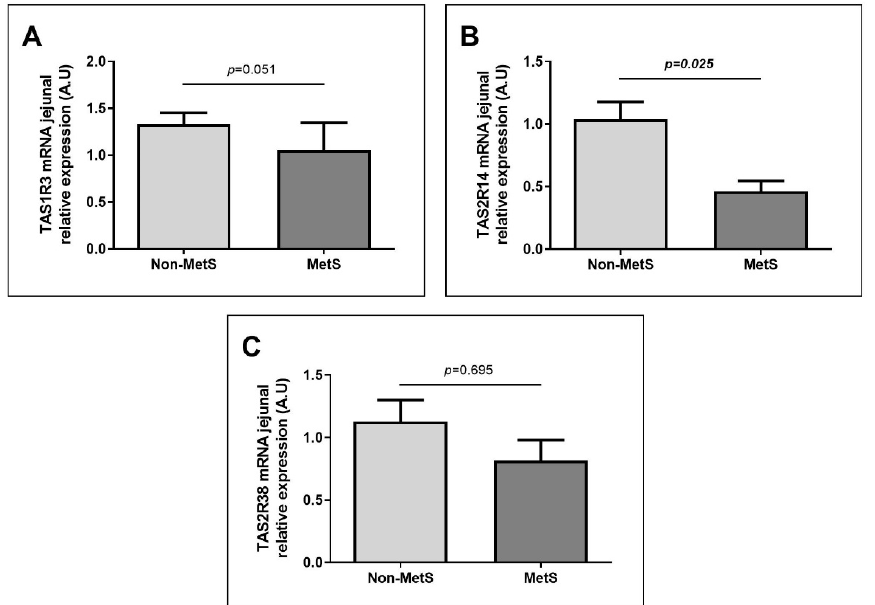
Figure 2. Differential JRE of TAS in women with morbid obesity classified according to the presence or absence of MetS ( A ) TAS1R2 JRE of women with or without MetS. ( B ) TAS2R14 JRE of women with or without MetS. ( C ) TAS2R38 JRE of women with or without MetS A.U, arbitrary units; Non-MetS, non-metabolic syndrome; MetS, metabolic syndrome; TAS1R3, taste 1 receptor family 3; TAS2R14, taste 2 receptor family 14; TAS2R38, taste 2 receptor family 38. p < 0.05 was considered statistically